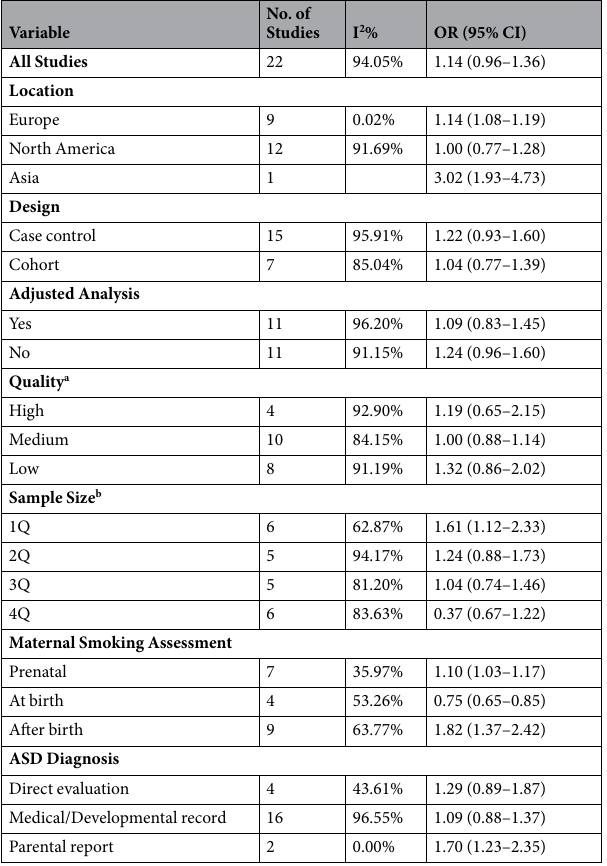
Table 1. Summary of results from subgroup analyses. a Averaged NOS scores of 8–9 (high), 6–7 (medium),